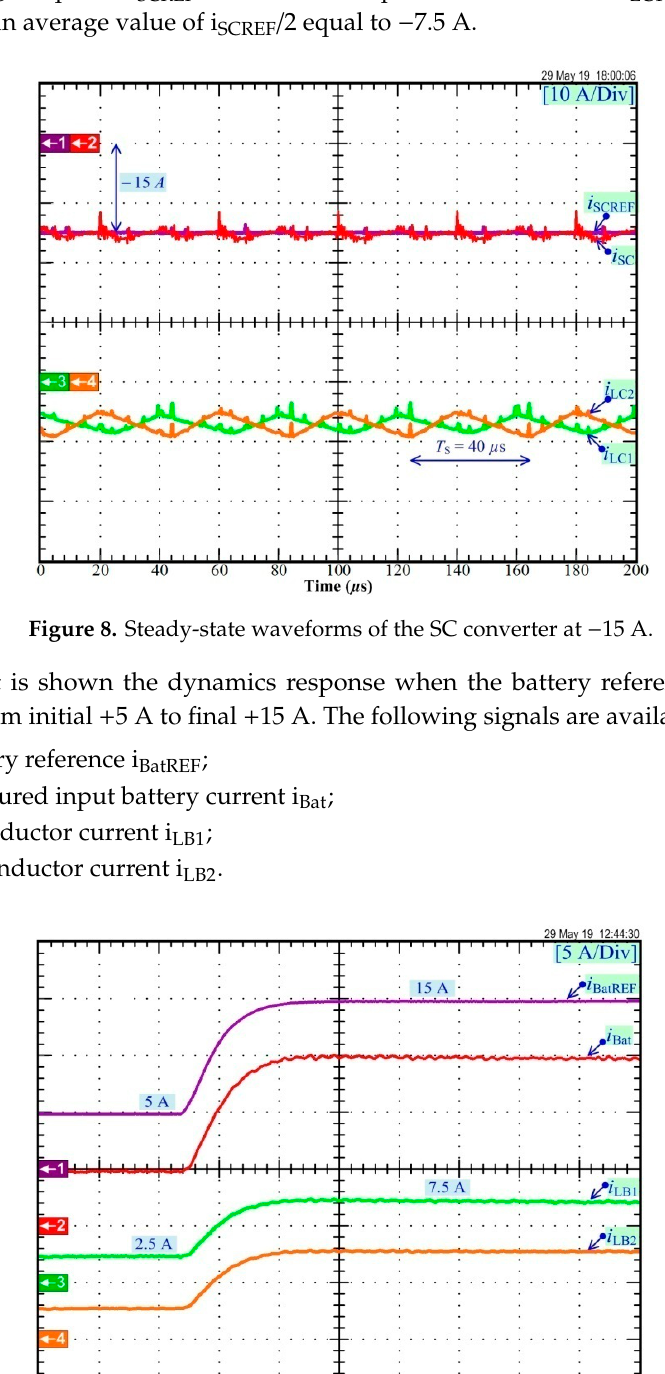
Figure 10. Experimental results: SC current response during i SCREF changing from 5A (discharging) to − 5 A (charging).